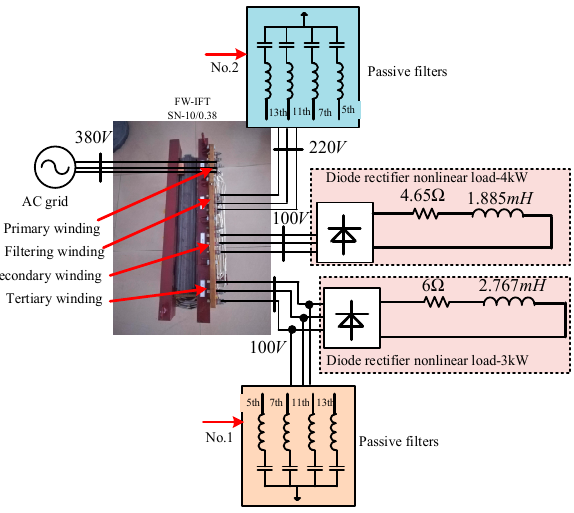
Figure 6. Electrical connection of the experimental system.